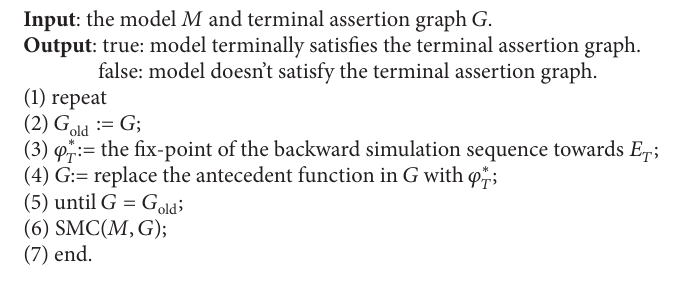
Algorithm 1: TMC (𝑀,𝐺)